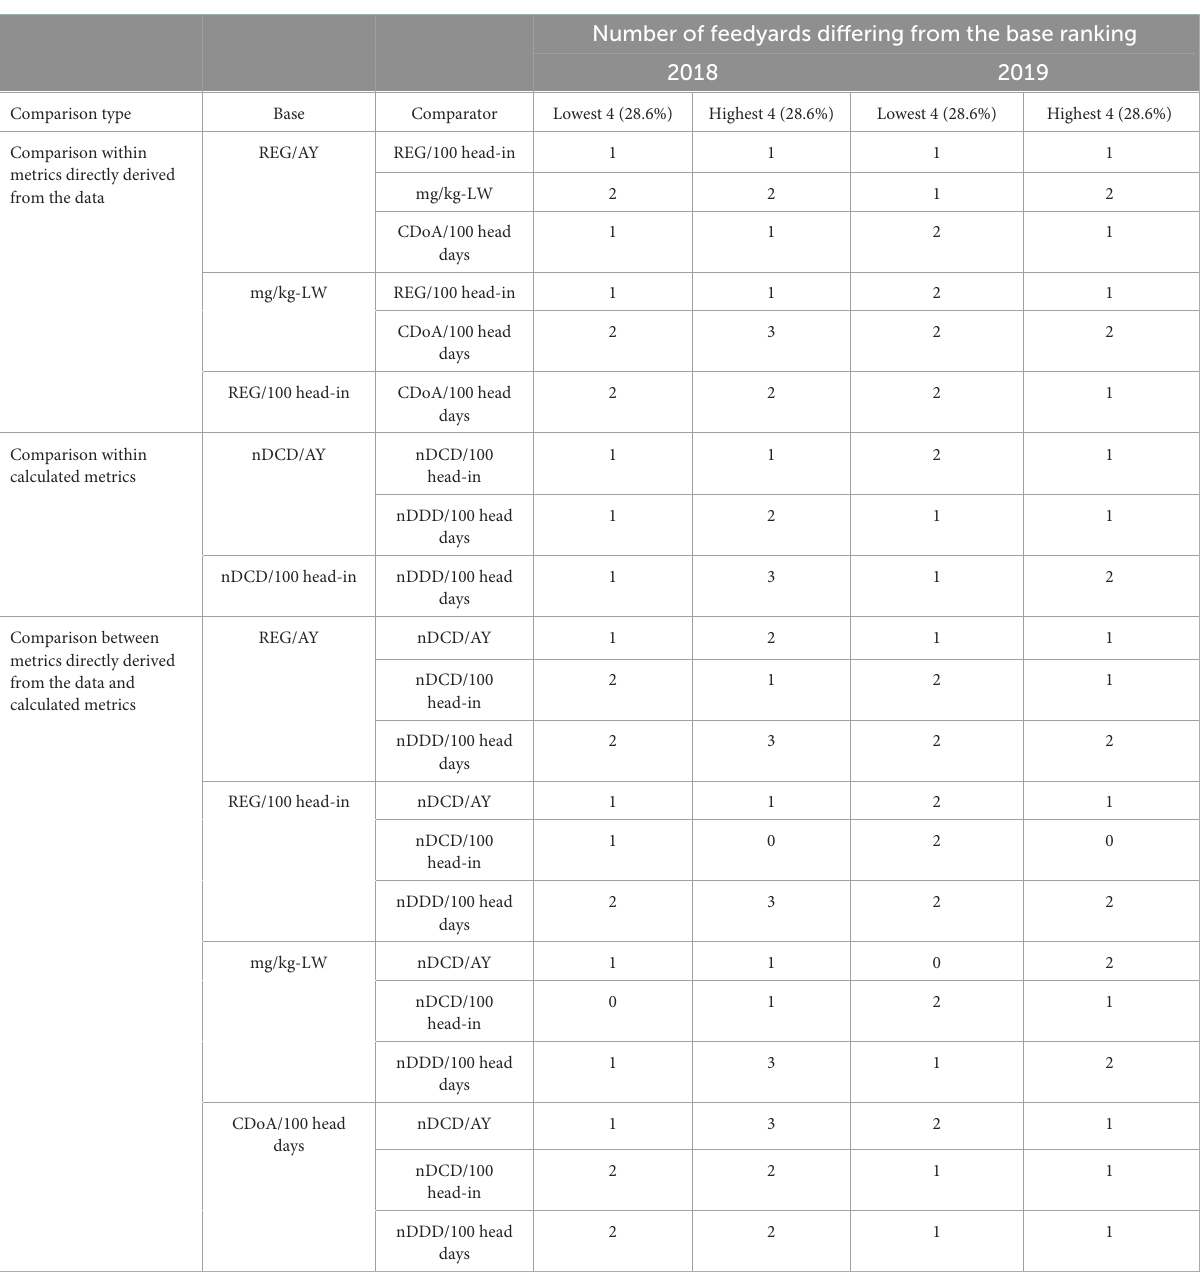
TABLE 5 Differences in feedyards ranked in the lowest or highest 4 feedyards as compared to the designated base